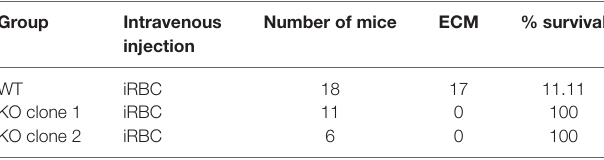
TaBle 3 | PbmaLS_05 ( − )-infected mice do not develop experimental cerebral malaria (ECM) even after injection of iRBCs. group